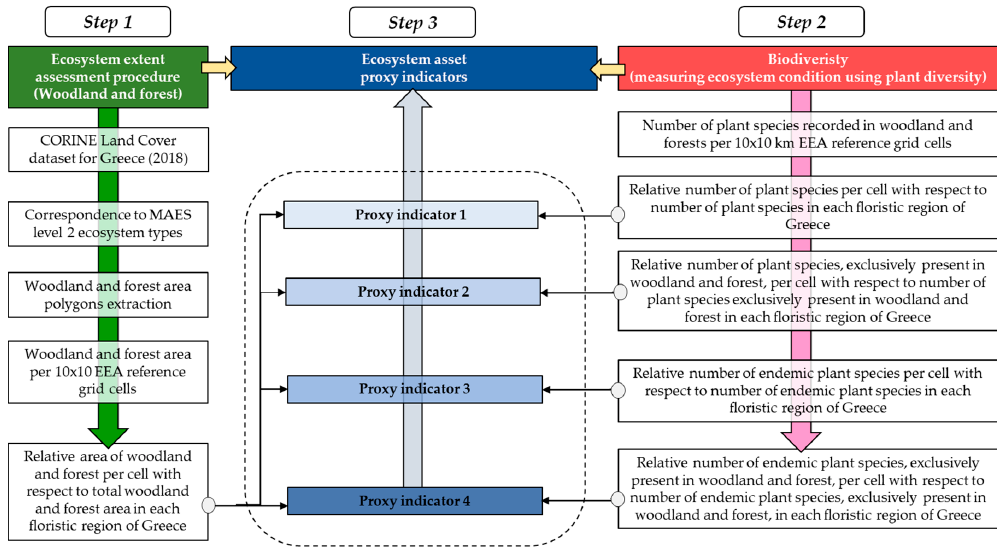
Figure 2. Methodological flowchart for developing and assessing ecosystem asset proxy indicators.